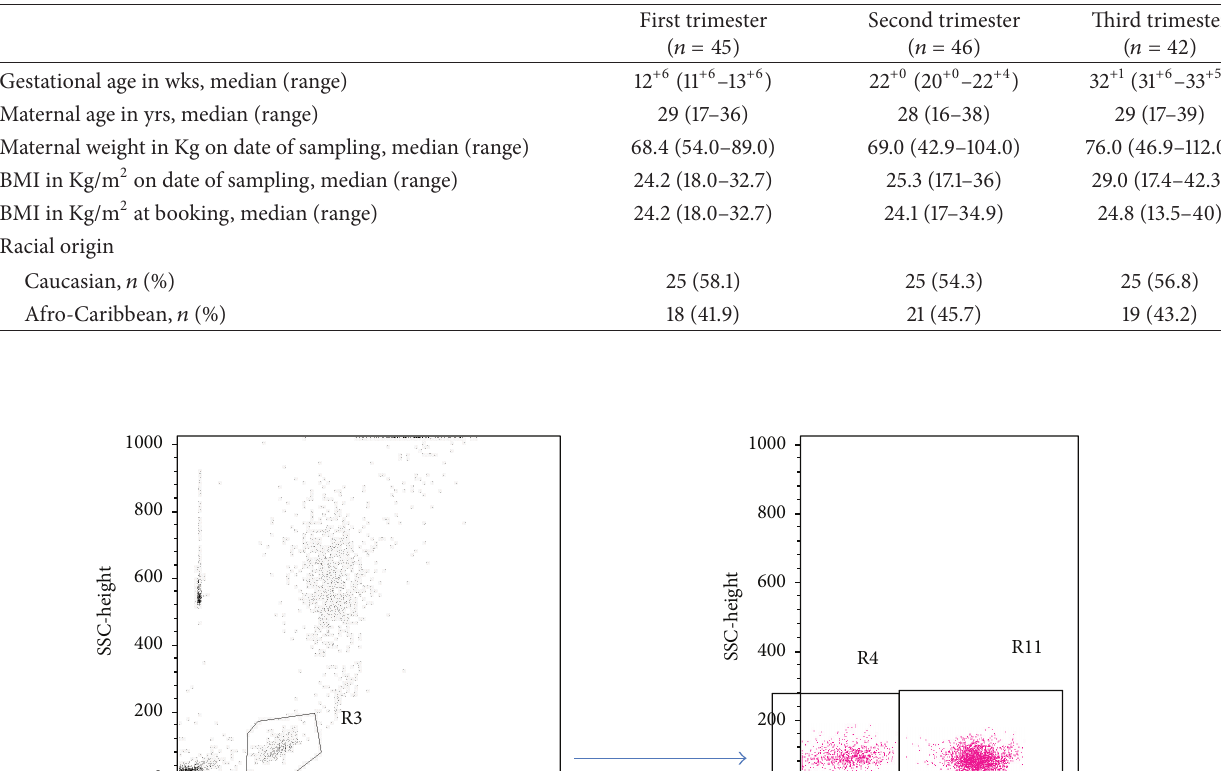
Table 1: Characteristics of the study population (median and range).